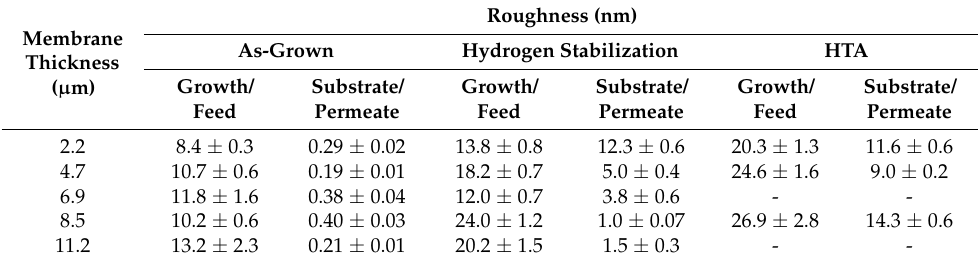
Table 4. Surface roughness for as-grown membranes, after hydrogen stabilization and HTA with subsequent hydrogen stabilization obtained from AFM imaging analysis for both the growth/feed and substrate/permeate side. The analyzed areas are based on (5 × 5) µ m 2 images except for the substrate/permeate side as-grown membranes where images with an area of (1 × 1) µ m 2 are